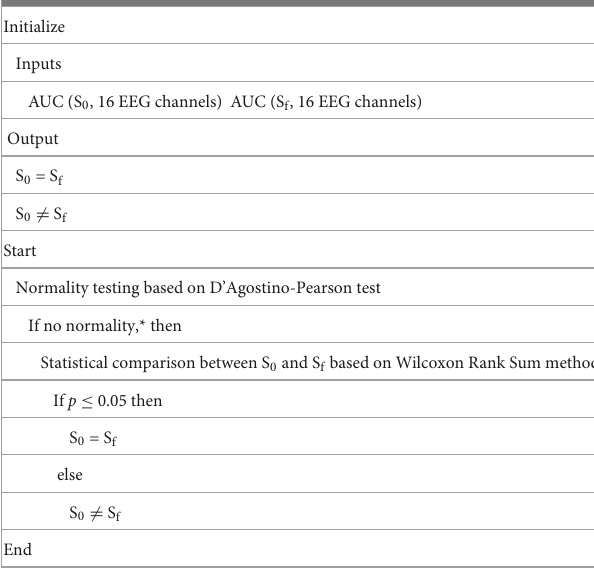
of individual alpha band oscillation, that is, IAF. Note that this parameter (IAF) is a neural print, which is highly inheritable, and